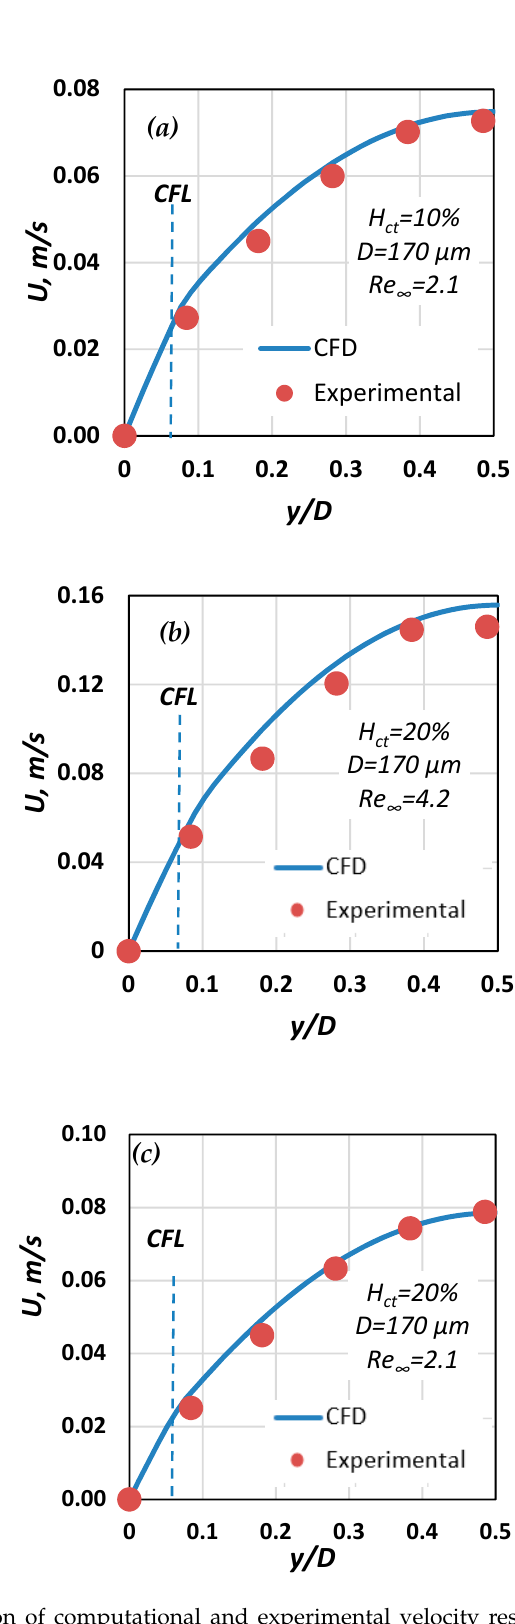
Figure 15. Comparison of computational and experimental velocity results for three cases with D = 170 µ m: ( a ) H ct = 20%, Re ∞ = 2.1; ( b ) H ct = 20%, Re ∞ = 4.2; ( c ) H ct = 10%, Re ∞ = 2.1.